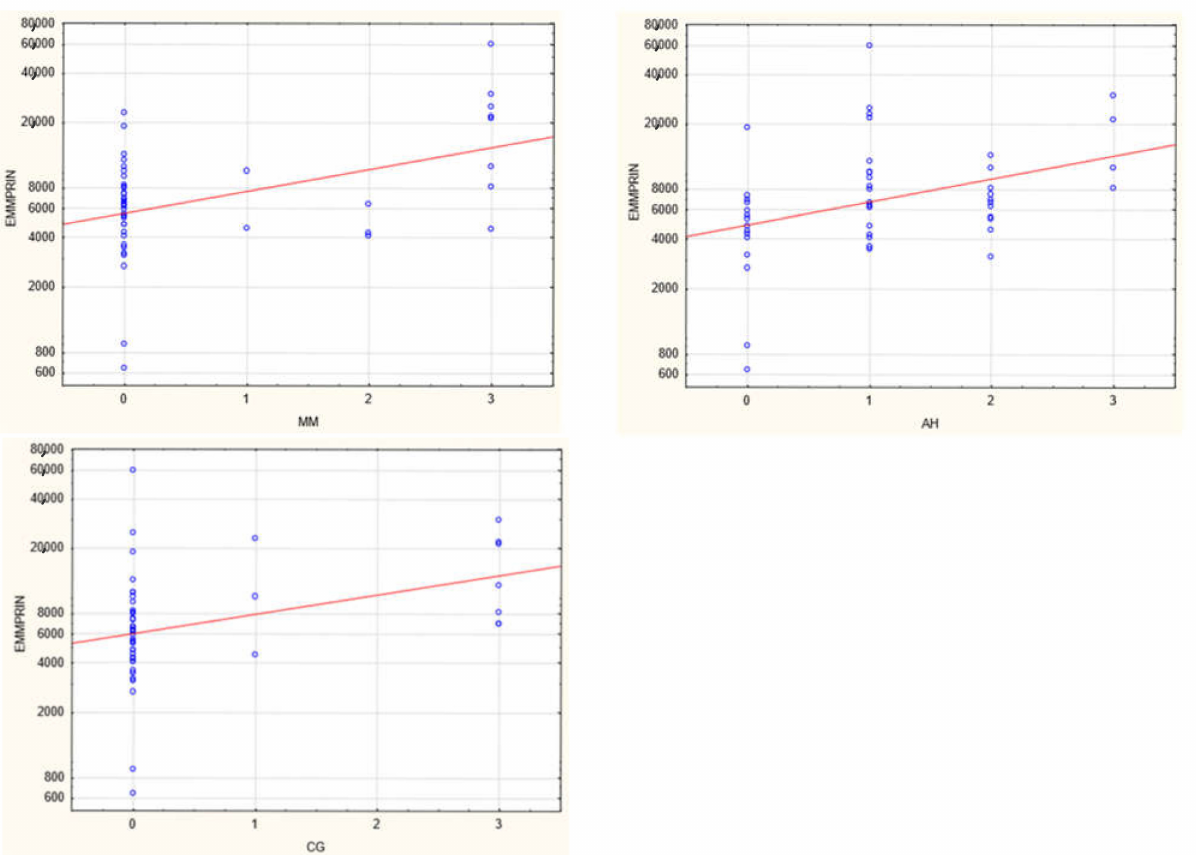
Figure 5. Positive correlation between EMMPRIN/CD147 serum concentration and severity of biopsy specimen lesions such as CG, MM, and AH (R = 0.41, R = 0.32, R = 0.40, respectively, p <